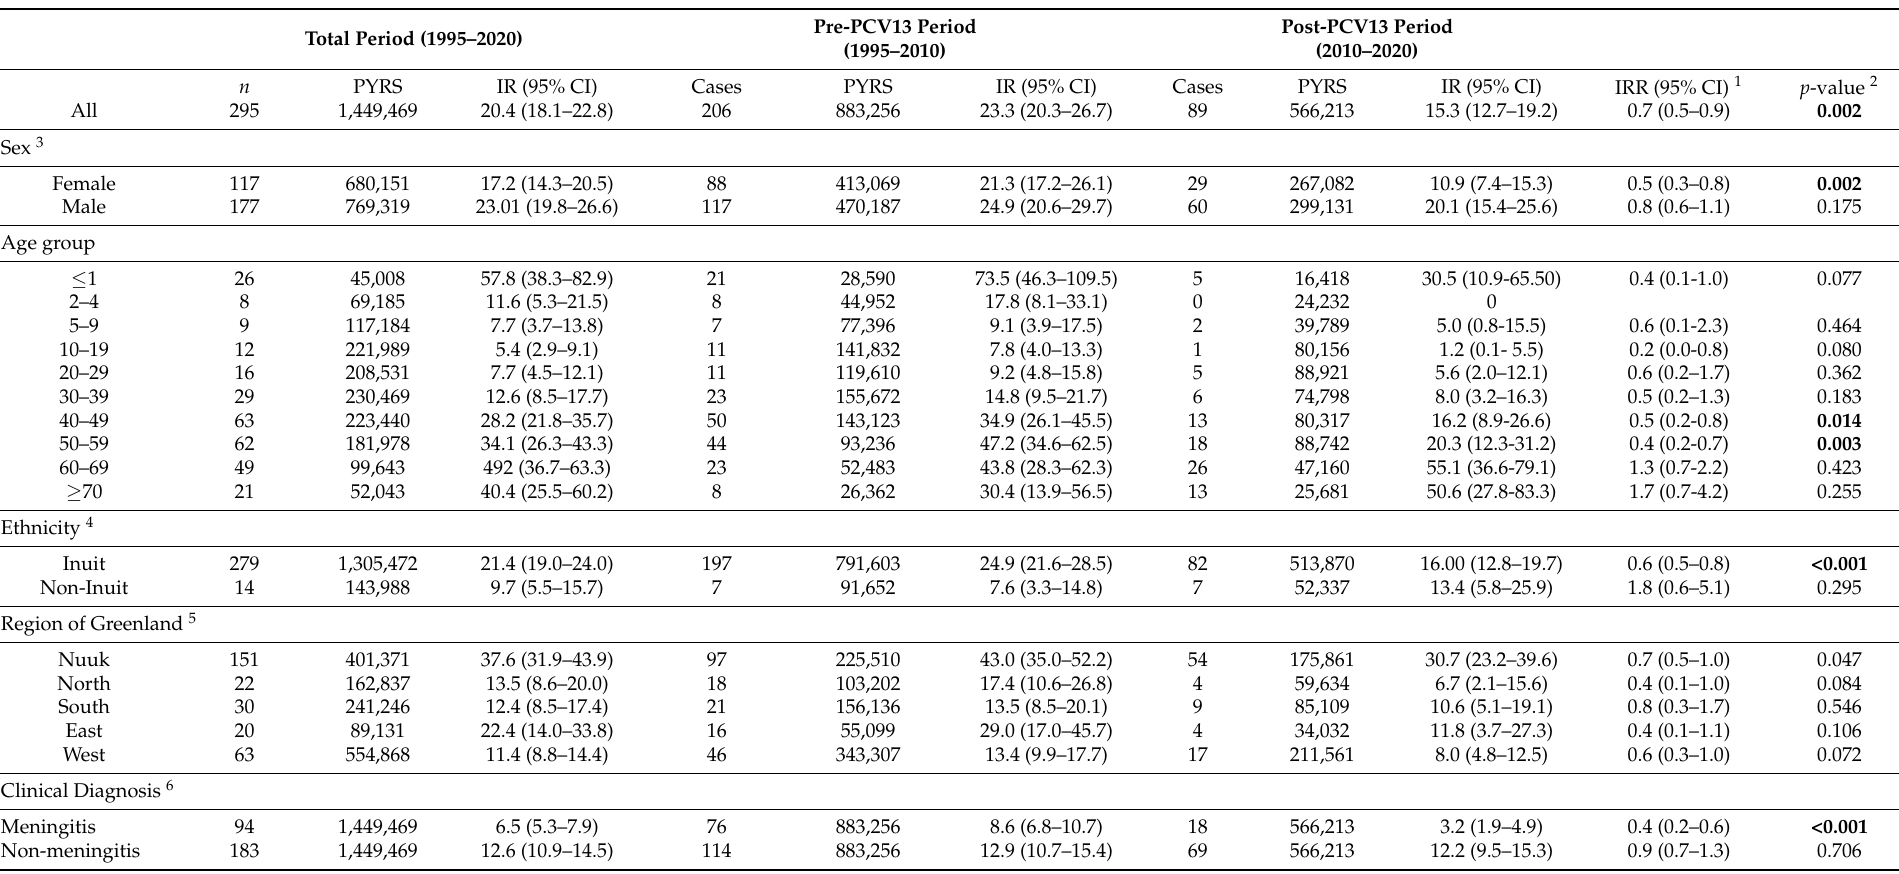
Table 3. Incidence rates and incidence rate ratios of invasive pneumococcal disease (IPD) per 100,000 person years in Greenland 1995–2020, overall, pre (1995–2010), and post (2010–2020) introduction of the 13-valent pneumococcal conjugate vaccine (PCV13) to the childhood vaccination program in 2010 in